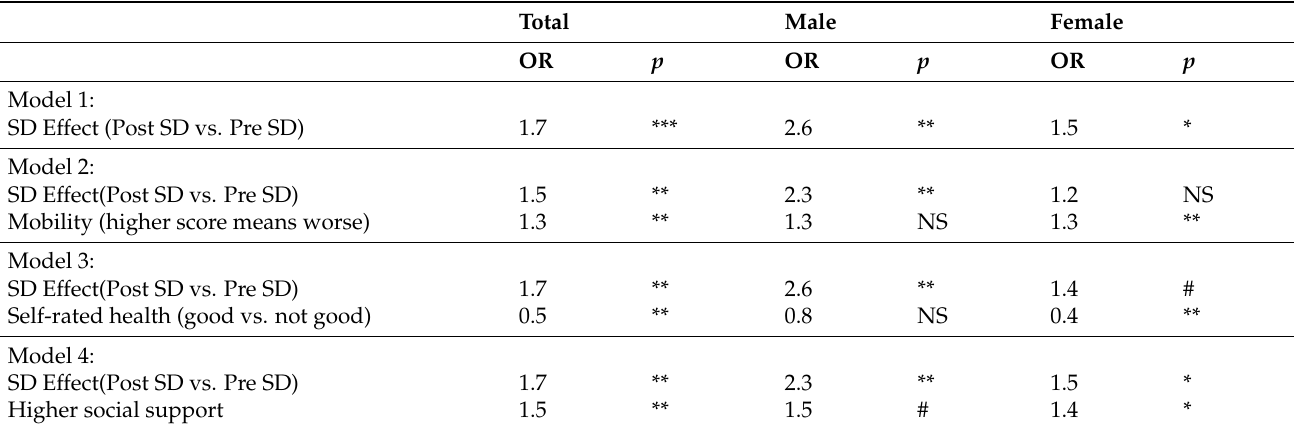
Table 5. Effect of spouse death on depression: multiple conditional logistic regression. Total